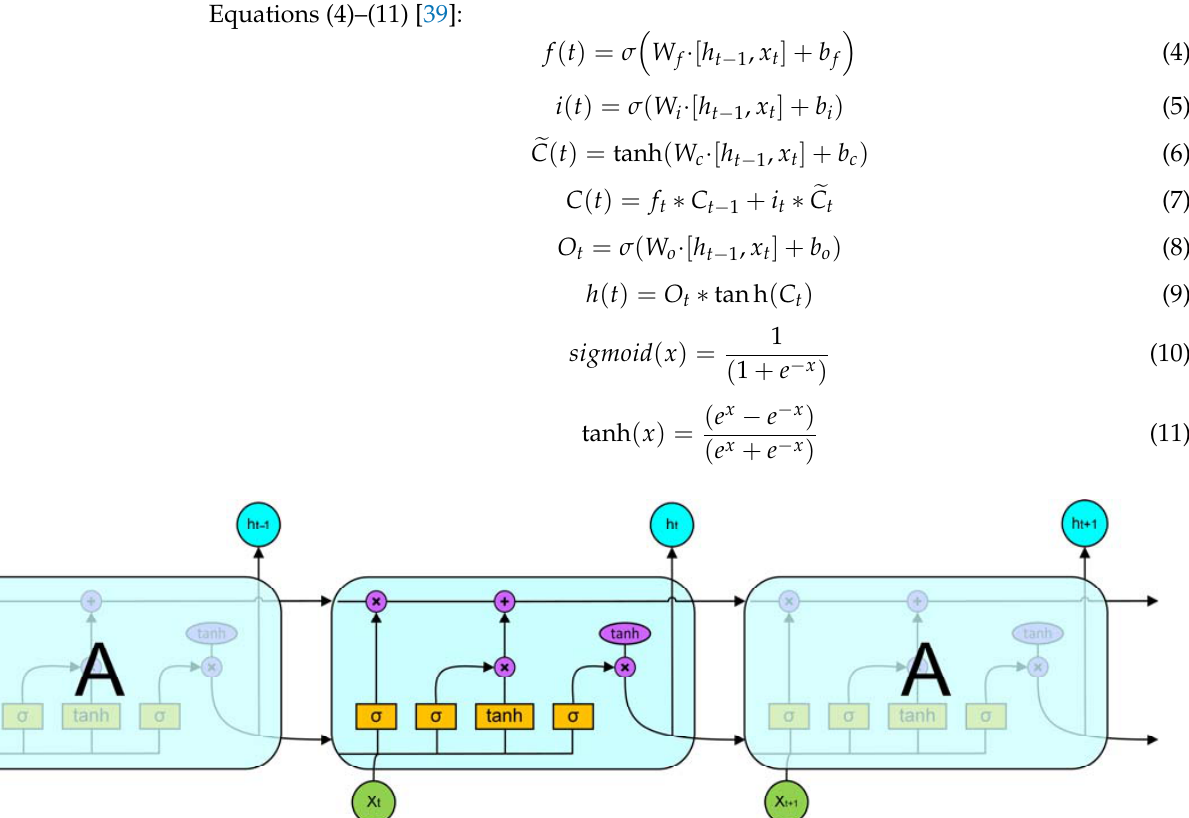
Figure 5. The basic LSTM network architecture for regression